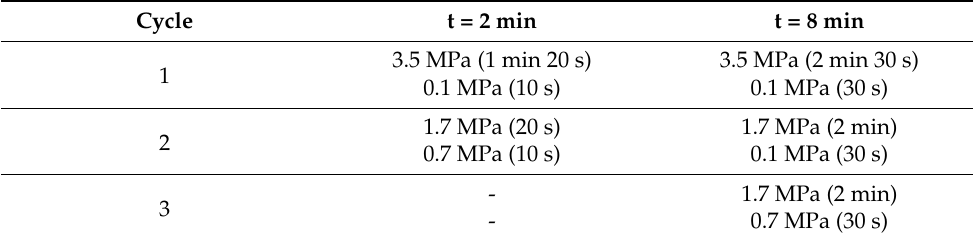
Table 3. Duration of the hot-pressing